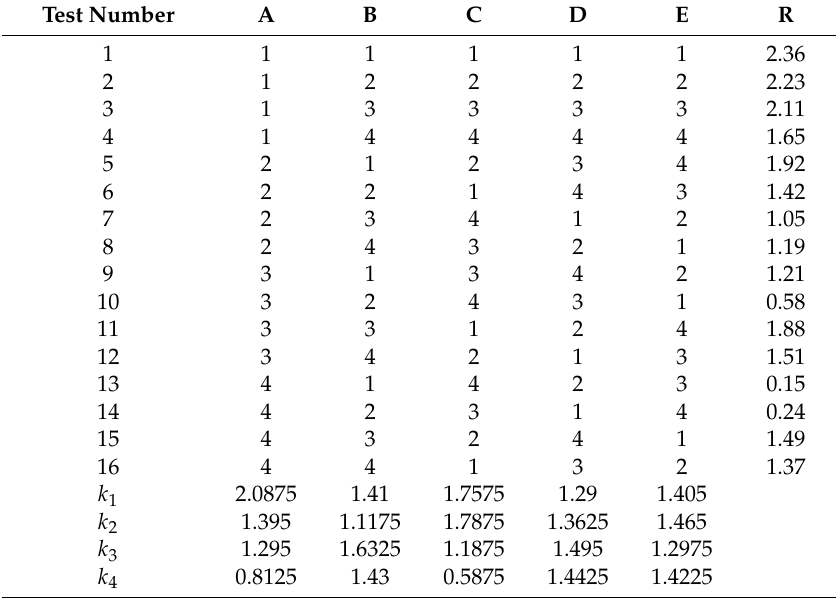
Table 2. Orthogonal test results of pH-sensitive membrane composition ratio.